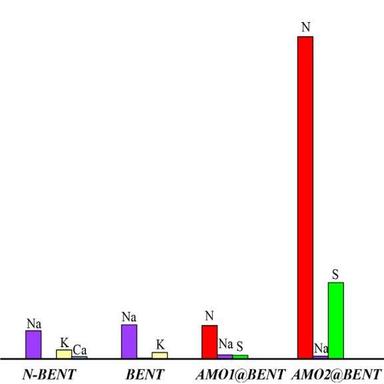
The comparison of the interlayer N, Na, S, K and Ca elements content in N-BENT, BENT, AMO1@BENT and AMO2@BENT materials.